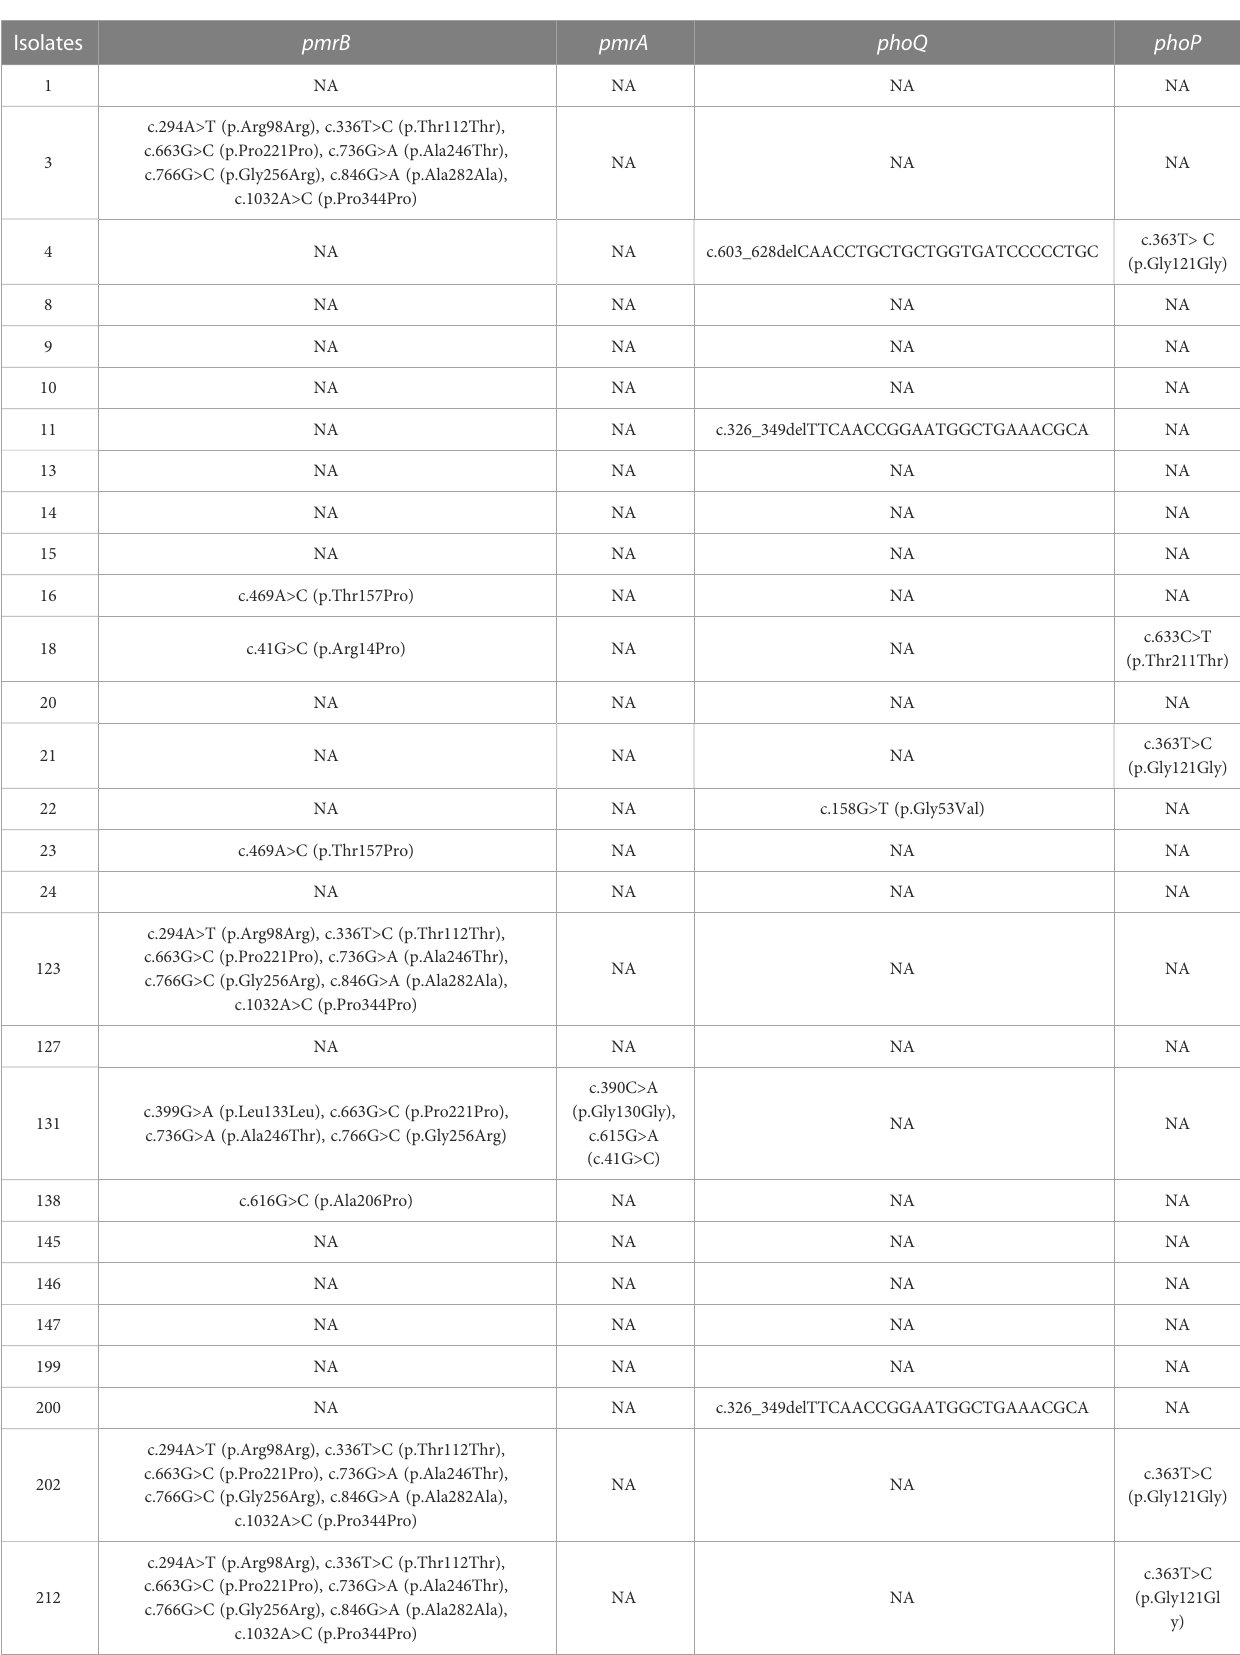
TABLE 3 Genetic variations in pmrA , pmrB , phoQ , and phoP of the polymyxin-resistant K. pneumoniae isolates.